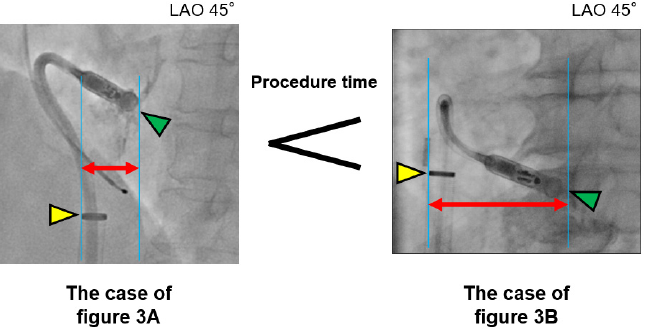
Figure 4. Schematic images of right atrium size and catheter push to the right ventricular septum. The delivery sheath in a larger right atrium ( right side ) may be far away from the right ventricular septum compared with that in a smaller right atrium ( left side ). Yellow triangles indicate the end of the sheath; green triangles, the edge of the Micra delivery system; and red arrows, the length from the right ventricular septum to the sheath. The scale magnification is the same between the two images.